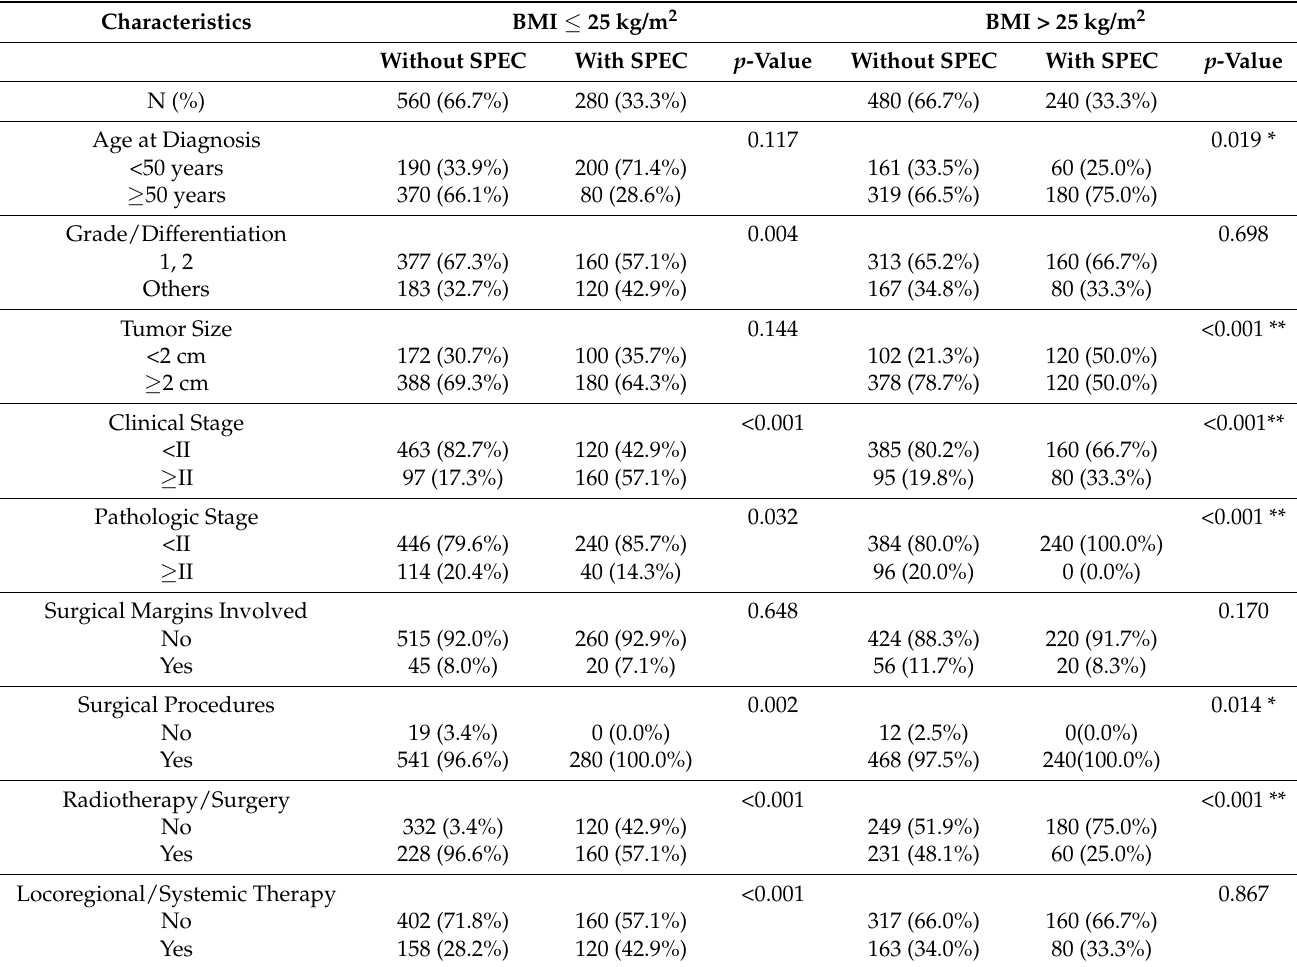
Table 6. The subject demographics of independent predictors of SPEC in primary endometrial